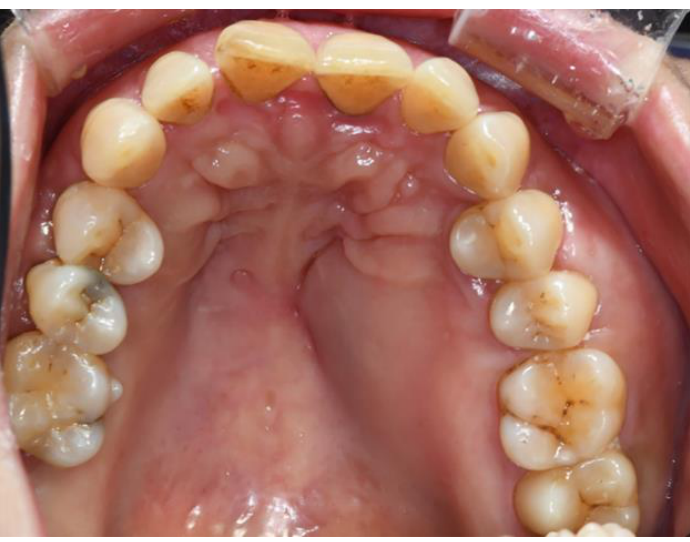
Figure 1. Expanded solid mass with intact soft tissue Involving the left maxilla area.